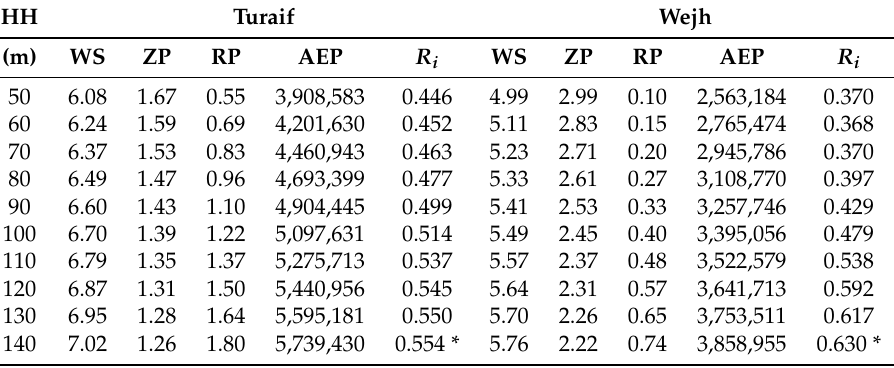
Table A6. TOPSIS analysis for turbine Enercon E-82 E2/2000. The best choice for each site is marked with an